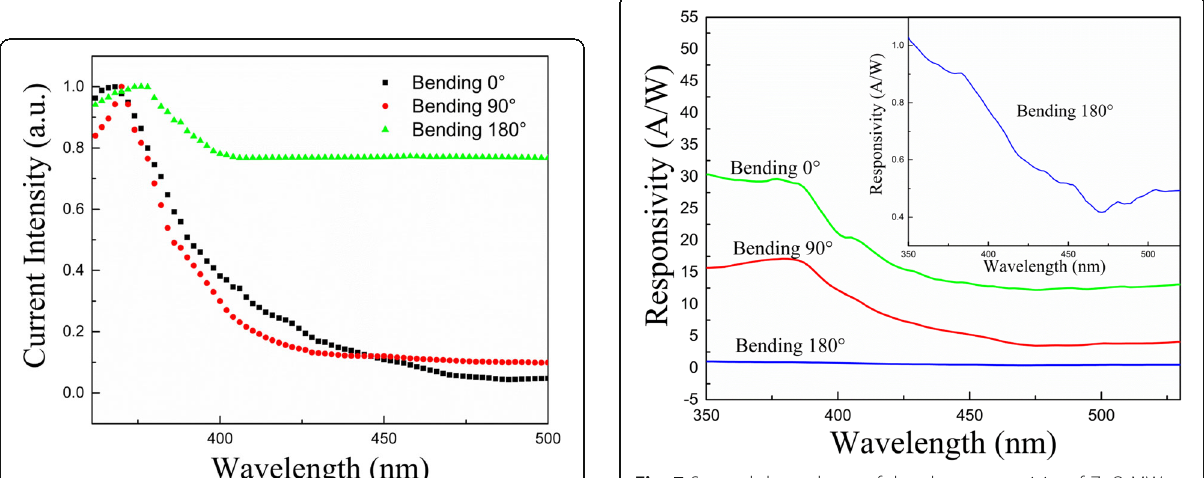
Fig. 7 Spectral dependence of the photoresponsivity of ZnO MW array UV PD at incident power of 1 μ W with 5 V bias at different bending angles (0°, 90°, and